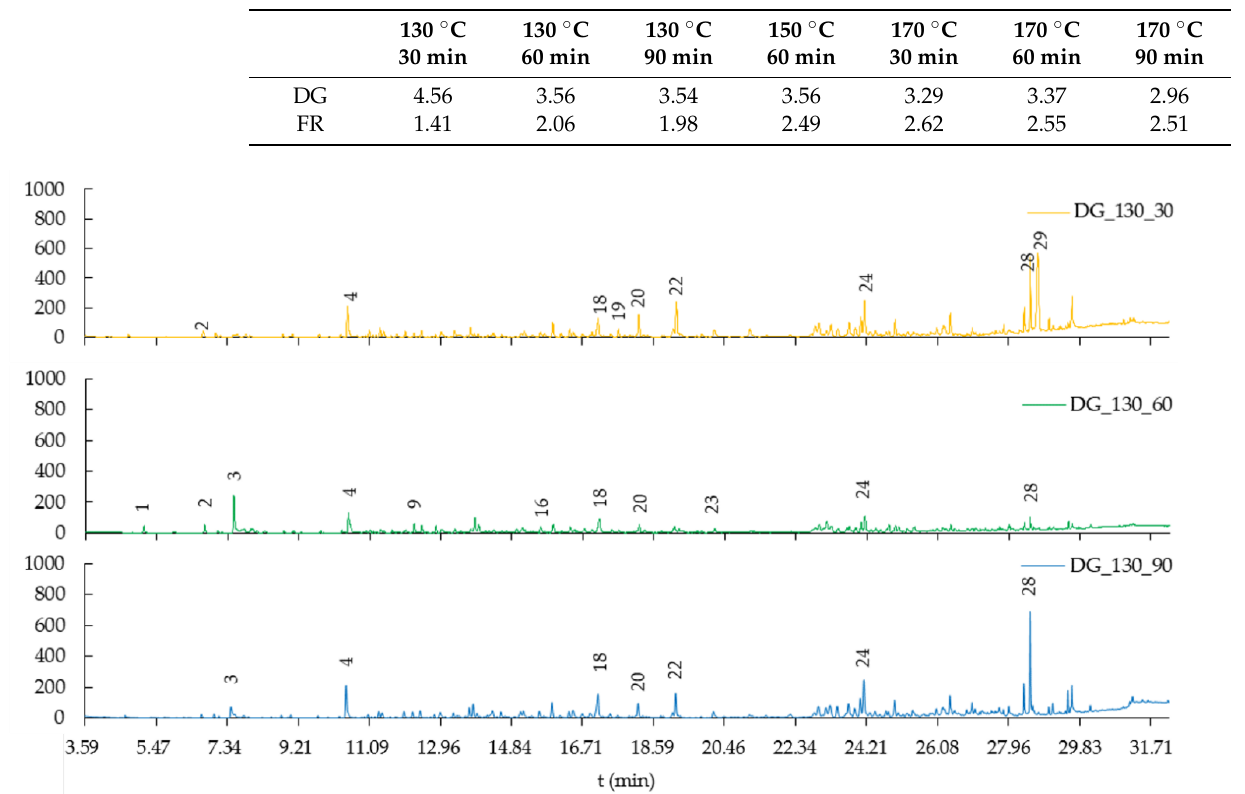
Table 5. pH values of the liquid products originating from the hydrothermal treatment of the digestate (DG) and forest residue (FR) at different temperatures and holding times.